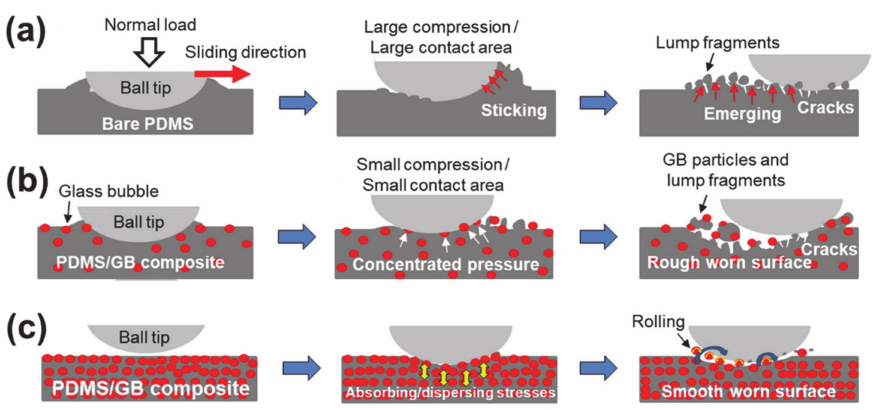
Figure 7. Schematic designs of wear mechanisms with respect to GB mixing ratio: ( a ) bare PDMS, ( b ) 100:(0.5–1), and ( c )